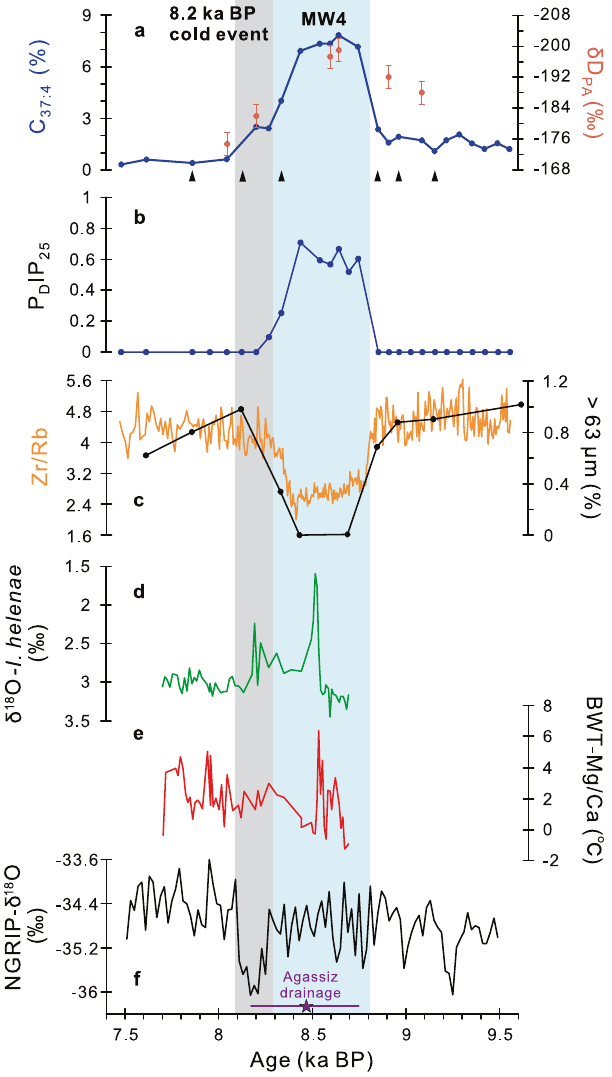
Fig. 5 Proxy records of MW4 versus the 8.2 ka BP cold event. a – c Proxy records for abrupt change during MW4 from Core MSM12/2-5-1. a %C 37:4 and stable hydrogen isotope composition of palmitic acid ( δ D PA ) as proxies for meltwater discharge (with higher C 37:4 and lower δ D PA representing lower salinity). Vertical error bars represent the standard deviation of the δ D ‰ ); b P PA measurements (3 D IP 25 as proxy for sea ice extent; c XRF-Zr/ Rb ratios indicating coarse versus fi ne-grained matter; percentage of coarse fraction (>63 μ m); ( d , e ) Proxy records for abrupt change around 8.5 ka BP from Core MSM45-19-2 12 : d δ 18 O of benthic foraminifera Islandiella helenae ; e Bottom water temperature estimates based on Mg/Ca ratios of I. helenae . f Greenland NGRIP- δ 18 O 4 . The age of ice core record was calculated to cal. ka BP from GICC05 age. The purple star indicates the age for Lake Agassiz drainage event: 8.47 ka BP with 1 σ uncertainties (purple line, 8.16-8.74 ka BP) 68 . Light blue shading shows MW4, whereas grey shading indicates the 8.2 ka BP cold event shown in the Greenland Ice Core. Black triangles mark available AMS 14 C